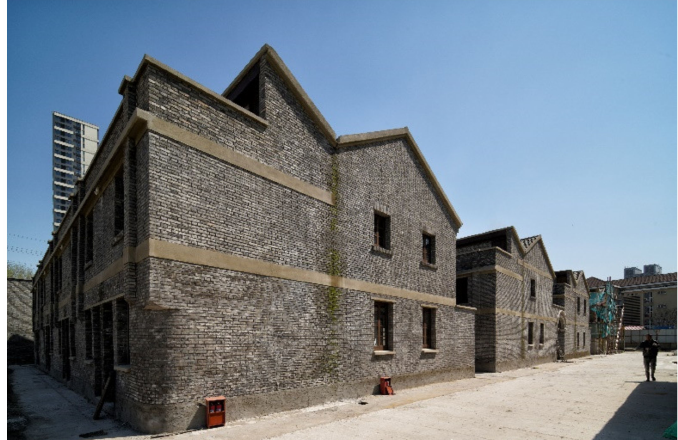
Figure 13. Buildings of “Tianbaoli”.